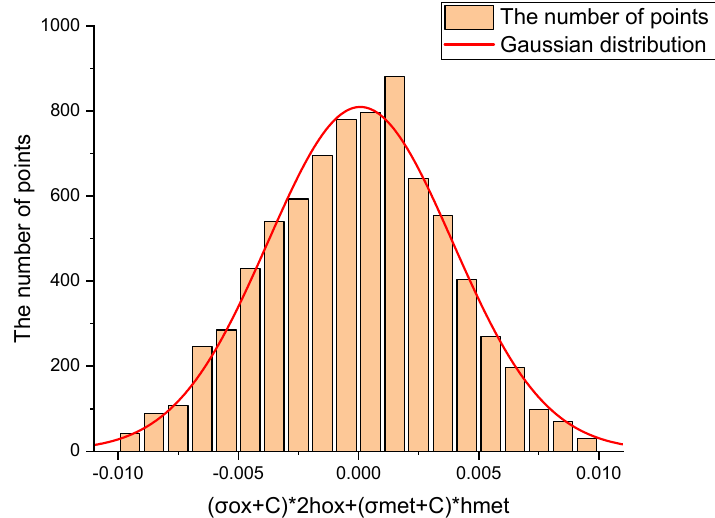
Figure 18. Number of points versus the value of ( σ ox + C ) × 2 × h ox + ( σ met + C ) × h met for R0.58.